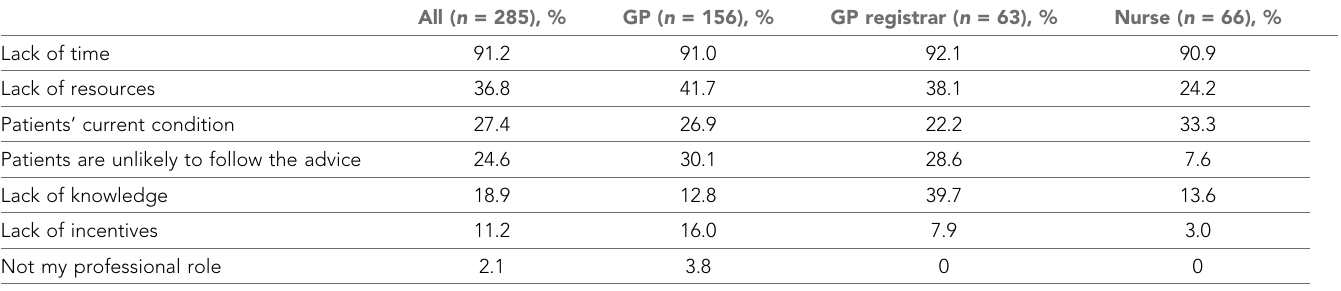
Table 2. Perceived barriers in limiting professionals from discussing physical activity with their patients All ( n = 285), % GP ( n = 156), % GP registrar ( n = 63), % Nurse ( n = 66), % Lack of